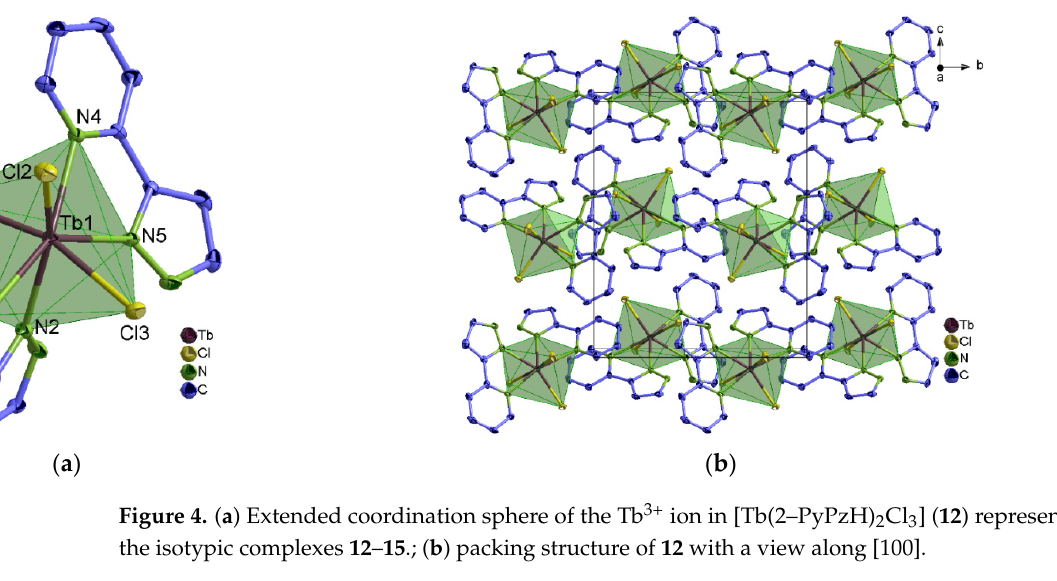
( b ) Figure 3. ( a ) Extended coordination sphere of the Ce 3+ ion in [Ce(2–PyPzH) 3 Cl 3 ] ( 11 ).; ( b ) crystal structure of 11 with a view along [100]. Another three complexes of the formula, [Gd 2 (2–PyPzH) 3 (2–PyPz)Cl 5 ] ( 16 ), [Gd 3 (2– PyPzH) 8 Cl 8 ]Cl ( 17 ), and [PyH][Tb(2–PyPzH) 2 Cl 4 ] ( 18 ), are formed as byproducts and crys- tallize in the monoclinic, triclinic, and orthorhombic crystal systems with the space groups P 2 1 / n , P ‾ 1, and Pb c n , respectively. In [Gd 2 (2–PyPzH) 3 (2–PyPz)Cl 5 ] ( 16 ) (Figure S3), both Gd 3+ are octa-coordinated; one is coordinated to four chlorides and four nitrogen atoms of a 2–PyPzH and a deprotonated 2–PyPz − in a distorted bicapped trigonal prism environ- ment. Two chlorine atoms along with the 2–PyPz − act as a bridge to the second Gd 3+ ion, which coordinates to another four nitrogen atoms of two 2–PyPzH and a chloride ion in a distorted triangular dodecahedron. For the anionic complex [Gd 3 (2–PyPzH) 8 Cl 8 ]Cl ( 17 ) (Figure S4), all three Gd 3+ ions are octa-coordinated, forming distorted triangular dodeca- hedral polyhedra, with two Gd 3+ ions coordinated to two Cl − ligands and six nitrogen at-